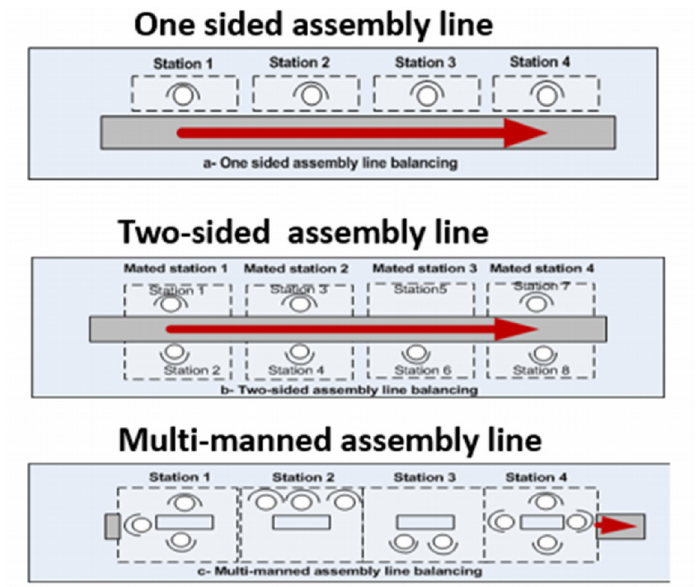
Figure 1. Types of assembly